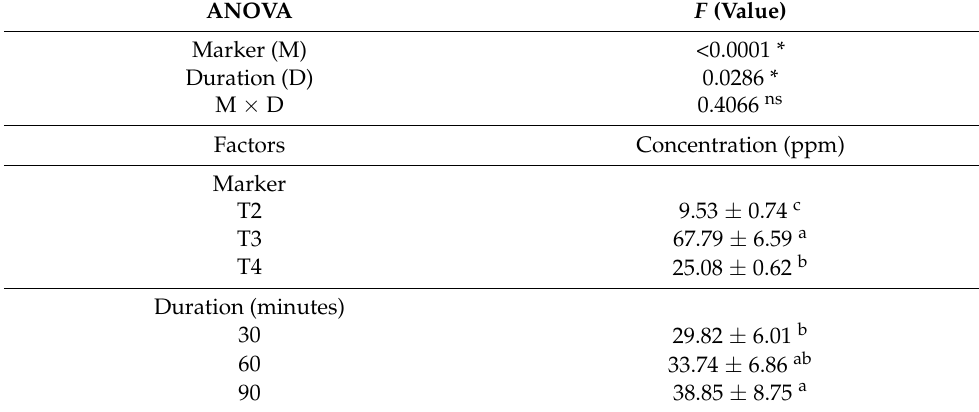
Table 2. Concentration of the markers Chromium Oxide (T2), Titanium Dioxide (T3) and NANOLIPE ® (T4) (mean ± standard deviation) found in Artemia at the exposure periods of 30, 60 and 90 min.